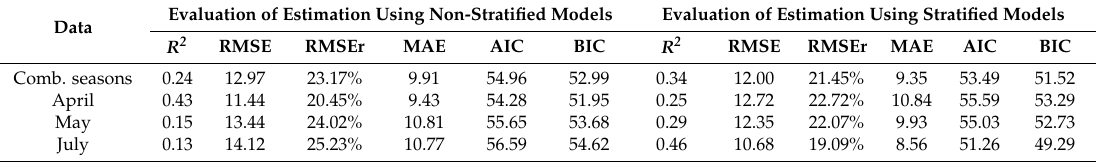
Table 8. Evaluation of estimation results using the non-stratification- and stratification-based